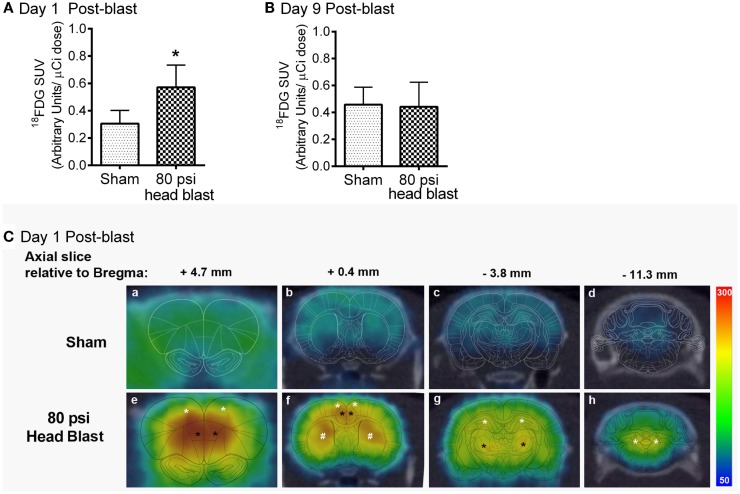
Transient increase in cerebral glucose metabolism was noted in the brain 1 day, but not 9 days, after an 80 psi head blast. 18F-FDG (radioactive glucose analog) SUVs in the whole brain following a 100 μCi i.v. dose were increased 1 day after blast TBI (A) compared to that in sham rats, but no differences were noted by day 9 (B) post-blast (Student’s unpaired t-test: *p < 0.05: n = 4–6/group). Data are presented as mean ± SEM (C). Representative axial PET/CT fused images of 18F-FDG uptake within the brain of a sham (a–d) and a blast (e–h) rat on day 1 post-blast. Images were overlaid with the corresponding rat brain atlas map as indicated in reference to distance from Bregma using Brain Navigator software (41). Images represented from a sham rat and an 80 psi head blast indicate that regions with highest intensity of 18F-FDG uptake (red > yellow > green > blue) were found in motor cortex (white * in e and f), frontal orbital cortex (black * in e and f), caudate putamen (white * in f), hippocampus (white * in g), thalamus (black * in g), and vestibular nuclei (white * in h).